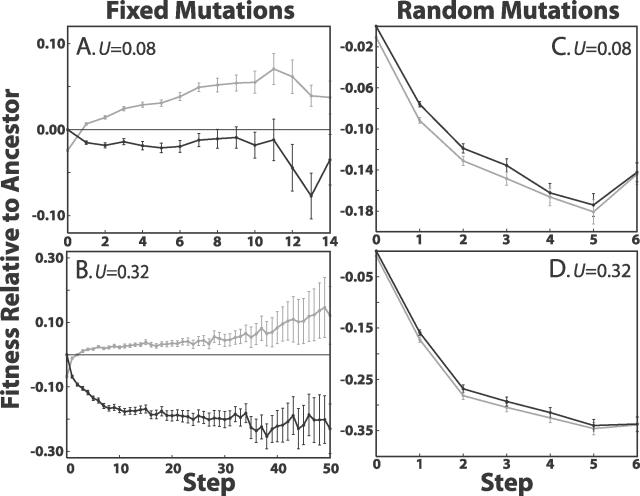
Fixed Deleterious Mutations Are Found in Genotypes That Are More Fit Than the Ancestral Genotype in Which the Deleterious Mutation AroseIn each graph, the gray lines correspond to gi and the black lines to
. We define the fitness of descendent genotypes relative to the ancestor as ((Wdesc − Wanc)/Wanc), where Wanc is the fitness of the parent genotype that gave rise to the deleterious mutation and Wdesc may mean the fitness of gi or
. The error bars depict one standard error of the mean. (A) and (B) show the change in fitness of the genetic backgrounds harboring the fixed deleterious mutations in the U = 0.08 and U = 0.32 runs, respectively. (C) and (D) show the change in fitness of the genetic backgrounds of random deleterious mutations that did not fix in the U = 0.08 and U = 0.32 runs, respectively.